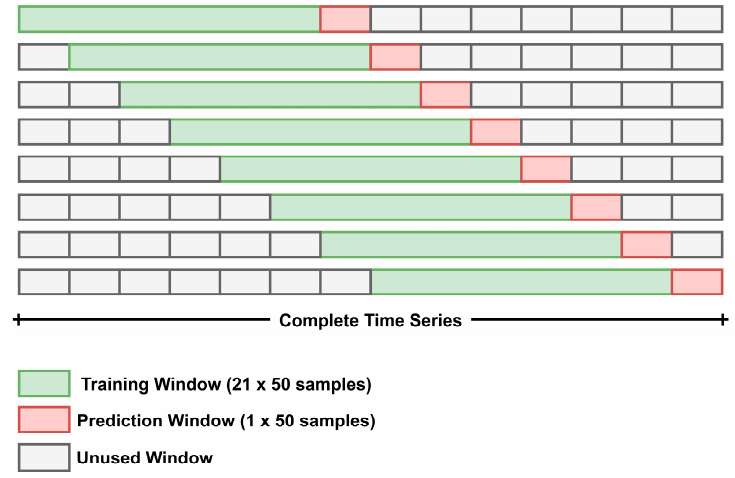
Figure 11 . Sliding window validation method for time series prediction models. Figure 11. Sliding window validation method for time series prediction